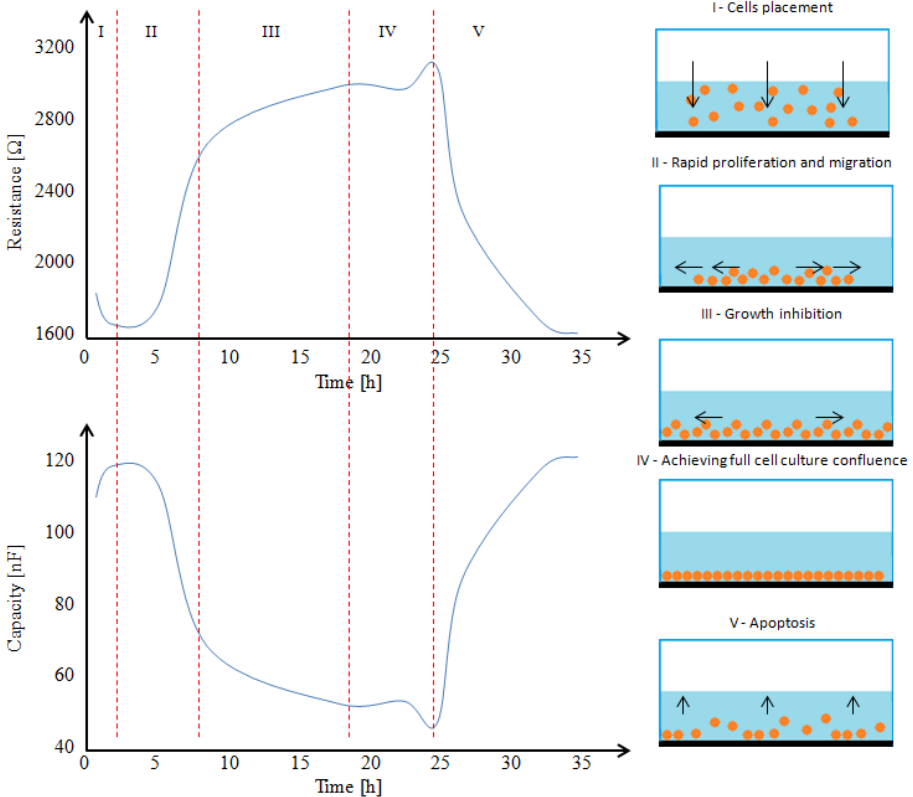
Figure 1. The expected nature of changes in the measured resistance for 4 kHz and capacitance for 64 kHz. Impedance measurement results at 16 kHz are usually very similar to the resistance graph. As the measured value of the resistance and the impedance increases, the value of the measured capacitance value decreases. In the first phase, cells are placed in the well with the medium (arrows indicate cell movement) (I). Then, cells migrate along the surface of the bottom of the container at a dynamic pace, multiplying (II). After this stage, cell growth (III) slows down, after which the cells occupy the entire bottom of the container, reaching full confluence and forming a monolayer (IV).